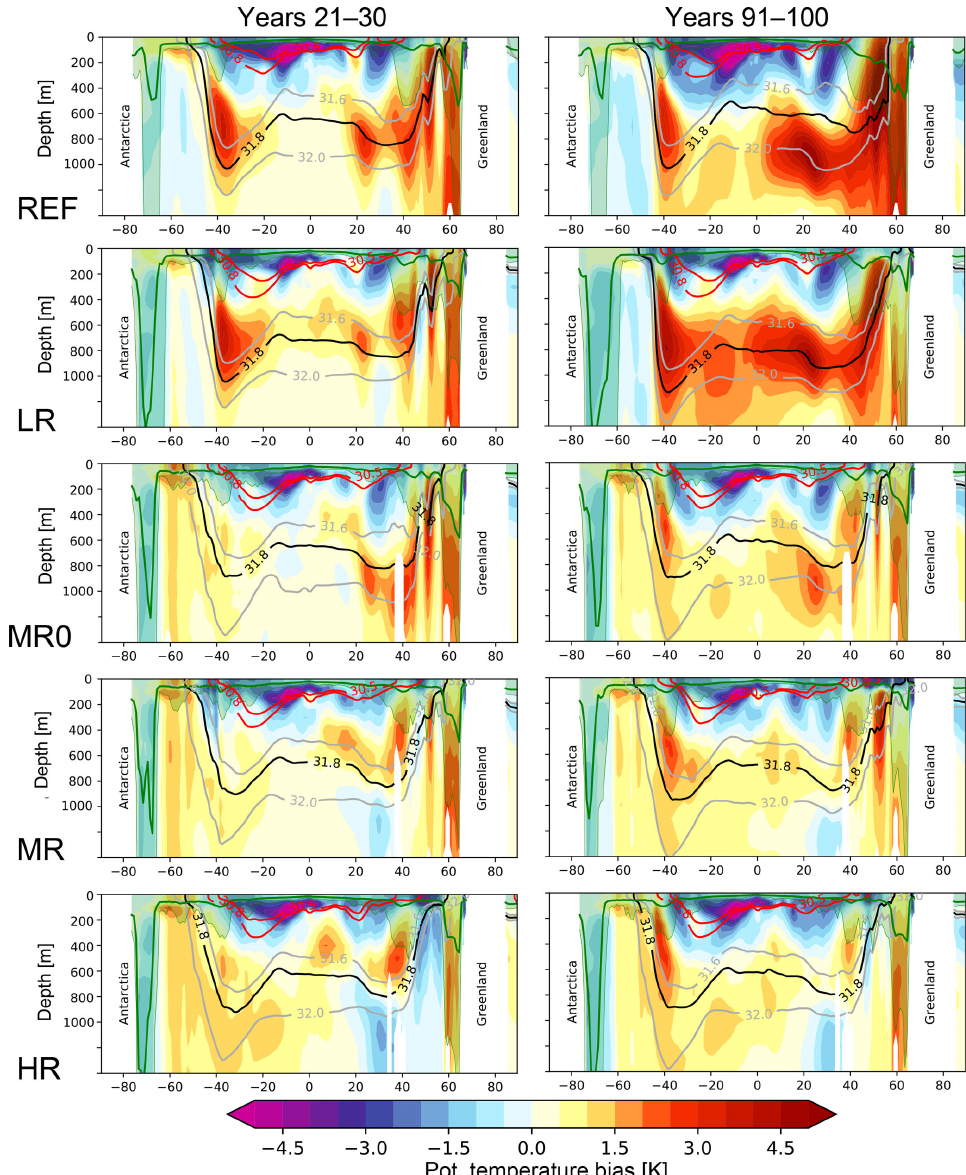
Figure 10. Meridional section at 30.5 ◦ W through the Atlantic Ocean for the potential temperature bias in the five simulations. The difference compared to PHC is shown with colors for years 21–30 (left column) and years 91–100 (right column), illustrating the North Atlantic bias development along isopycnal layers (see animations S3 and S4 for LR and HR with a 10-year running window in the Supplement videos; Rackow et al., 2018c). The contours show σ 1 density contours that are representative for the deep ocean between 600 and 1000m (gray and black; σ 1 = 31 . 6, 31.8, 32.0) and for the surface ocean until a maximum depth of about 300m (red; σ 1 = 30 . 5, 30.8). The average (maximum) mixed layer depth in the 10-year windows is overlaid with a green line (green